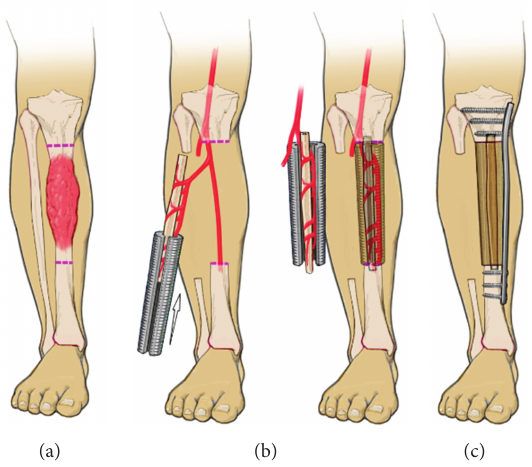
F 6: In orthopaedic oncology, vascularised �bula transfer is considered as one of the most suitable techniques for the reconstruction of critically sized defects of the tibia diaphysis due to the mechanical strength, the predictable vascular pedicle, and the hypertrophic potential of the �bula. Combining the autogra withalargeboneallogracanenhancethebiomechanicalproperties of the construct. However, the use of allogras can be associated withsigni�cantdrawbackssuchasimmunomediatedrejection,gra sequestration or transmission of infectious diseases. In addition, the acquisition costs are rather high. A novel biological approach customised tissue engineered bone construct. Aer tumor